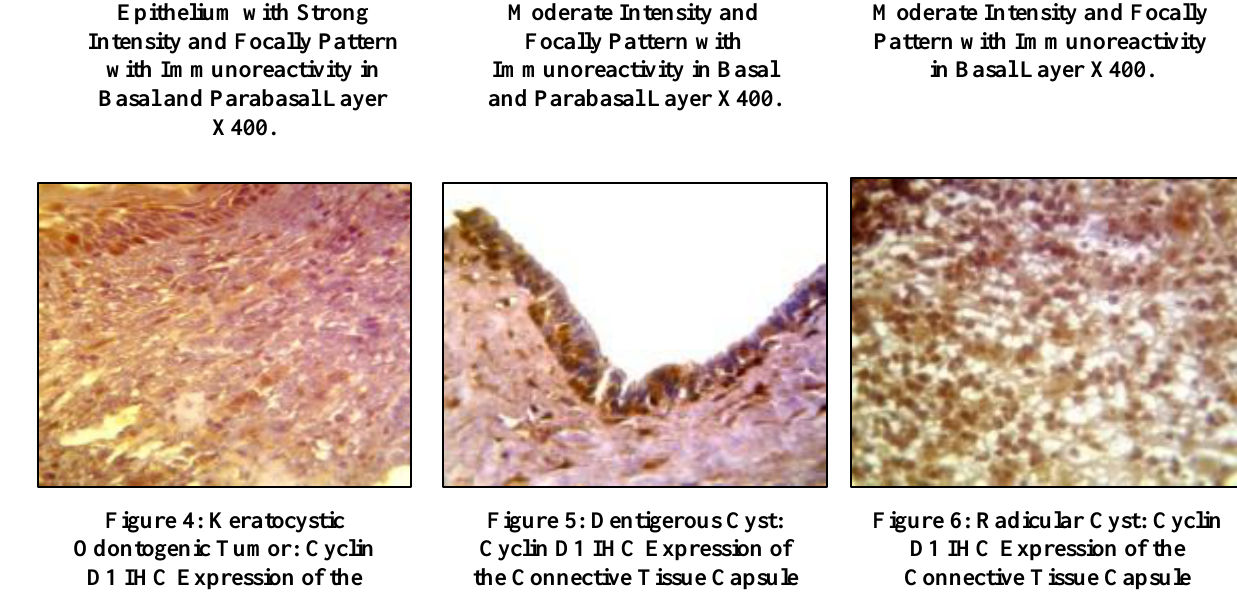
Figure 3: Radicular Cyst: Cyclin D1 IHC Expression of Cystic Epithelium with Moderate Intensity and Focally Pattern with Immunoreactivity in Basal Layer X400.